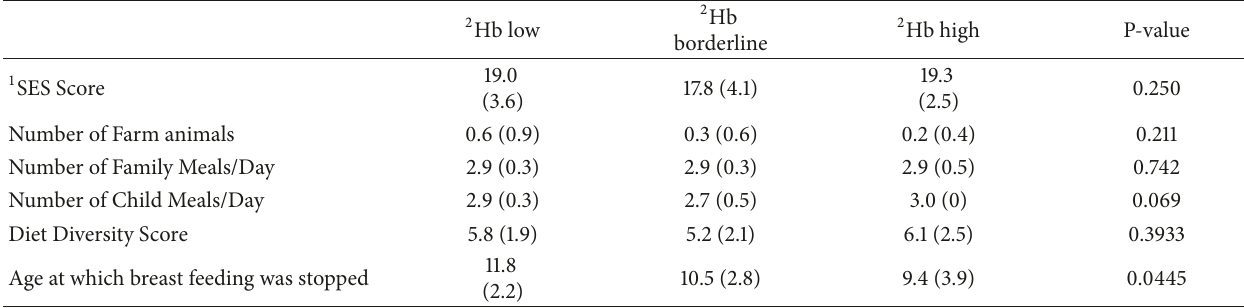
Table 3: Hemoglobin levels and diet